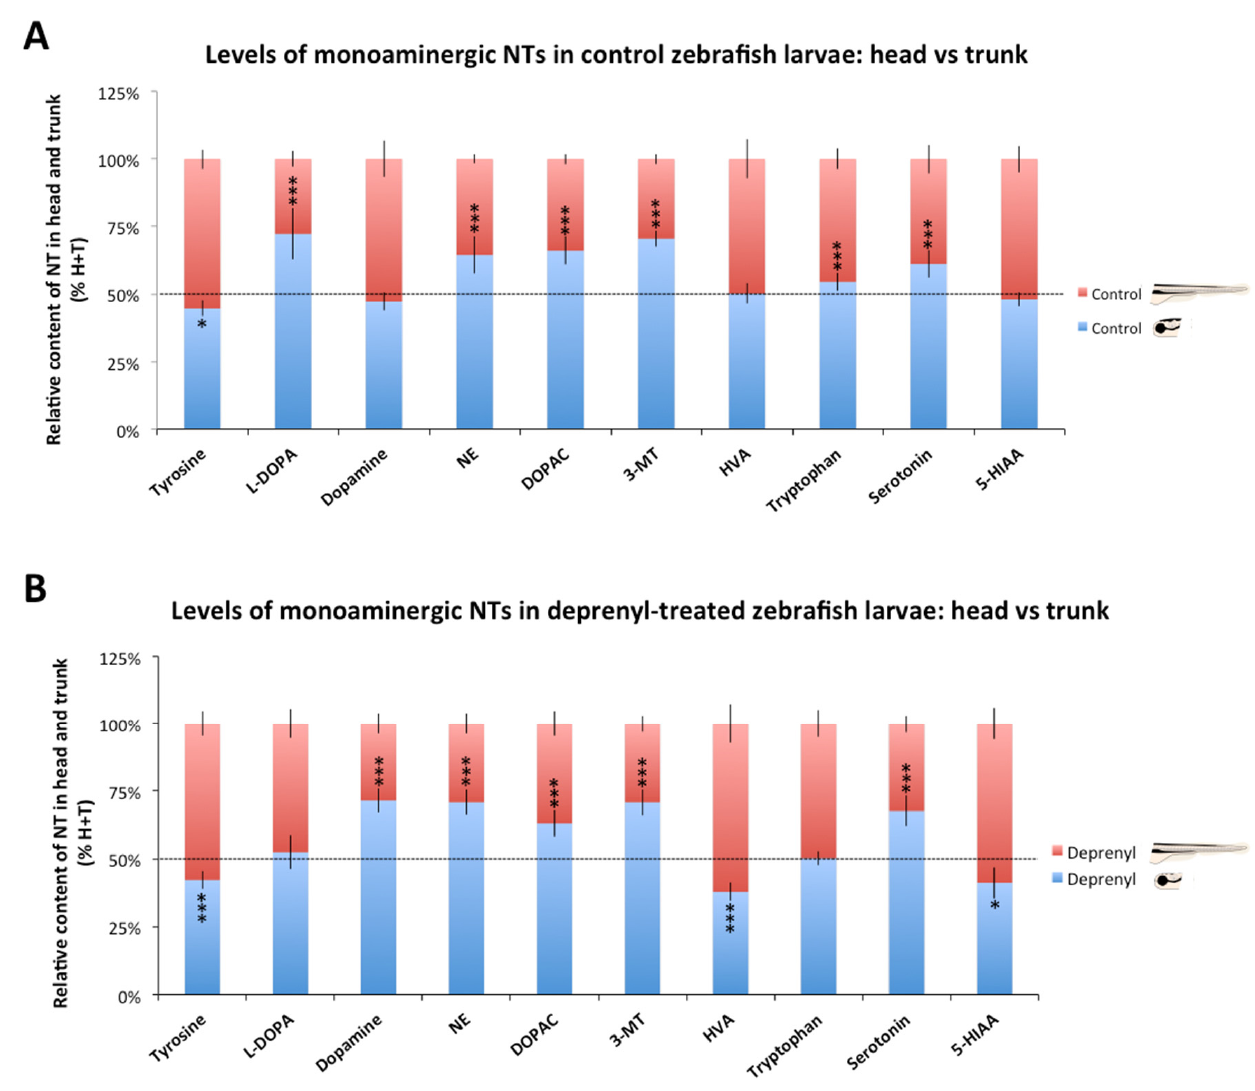
Figure 1. Levels of monoaminergic neurochemicals in the head and trunk of zebrafish larvae. ( A ) Distribution in the head and the trunk of control larvae 8 days post-fertilization (dpf); ( B ) Distribution in the head and the trunk of 8 dpf larvae exposed for 24 h to 5 µM deprenyl, a monoamine-oxidase inhibitor, in the water. Data were normalized by protein content (n = 8 pools) * p < 0.05, *** p < 0.001; Student’s t -test; Data from 2 independent experiments.